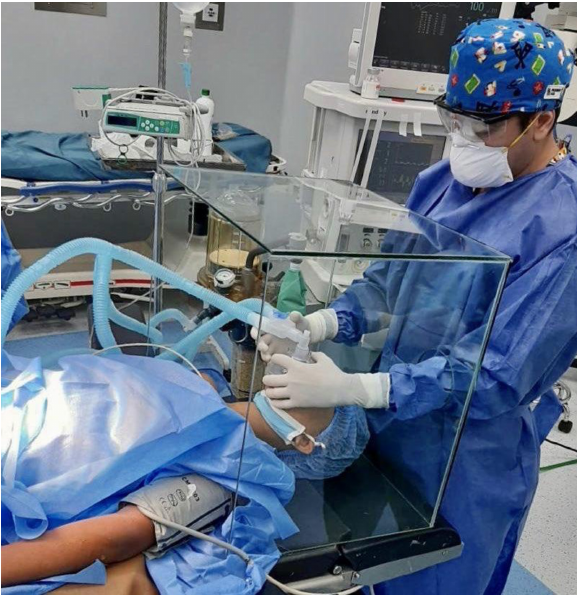
Figure 3 - Aspects of Endoscopic